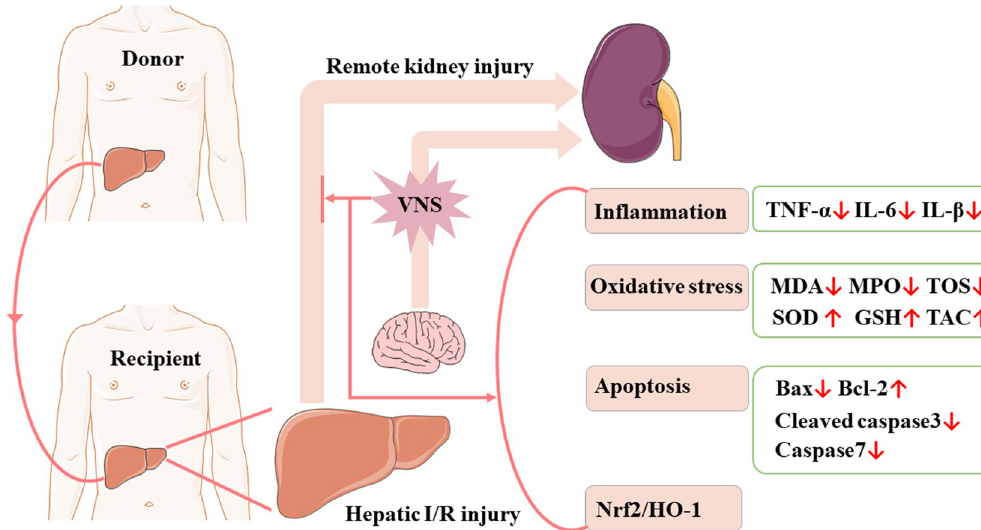
Figure 8. Schematic diagram depicting the protective effect of VNS on AKI after hepatic I/R injury and its potential mechanisms. VNS protects against AKI after hepatic I/R injury by suppressing inflammation, oxidative stress, and apoptosis probably via the Nrf2/HO-1 signaling pathway.